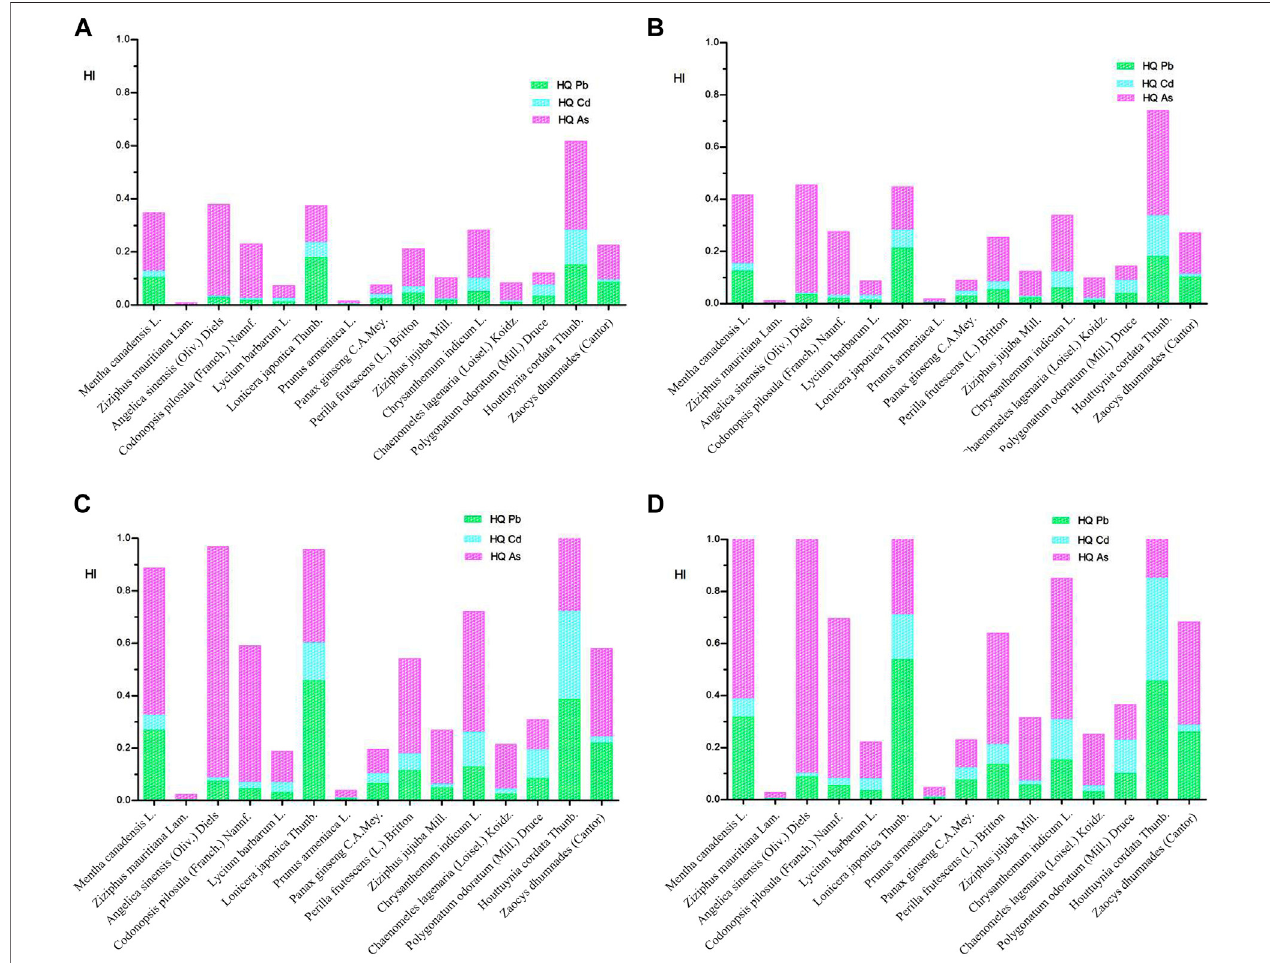
FIGURE 2 | HI of heavy metals in food homologous TCM. (A) HI of heavy metals in food homologous TCM used as TCM for male. (B) HI of heavy metals in food homologousTCMusedasTCMforfemale. (C) HIofheavymetalsinfoodhomologousTCMusedasfoodformale. (D) HIofheavymetalsinfoodhomologousTCMused as food for